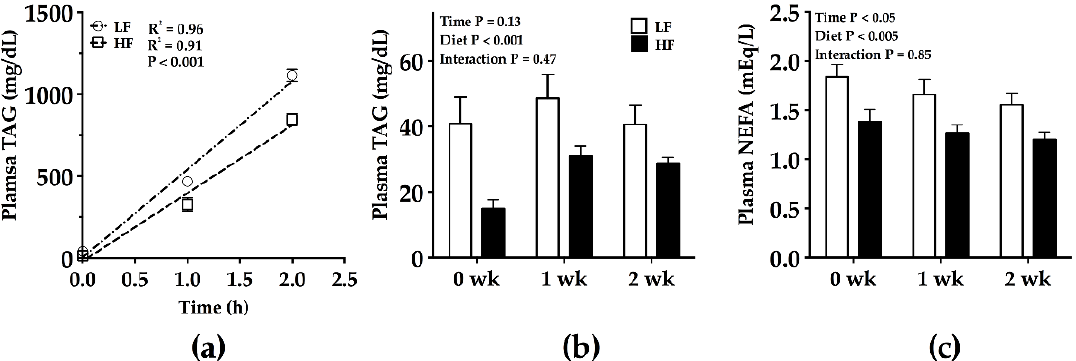
Figure 3. Plasma NEFA concentrations during the hepatic triacylglycerol production test (HTPT) in male C57BL/6J mice fed a low-fat (LF) or high-fat (HF) diet for 4 weeks. Mice were fasted 5–6 h prior to the HTPT (postabsorptive). Blood was sampled via a tail vein nick at 0 h (baseline), 0.5, 1, 2, and 6 h. One mouse was excluded from the NEFA data due to limited sample volume. Mean ± SEM. LF n = 9; HF n = 10.